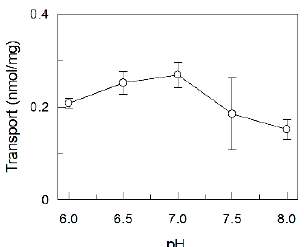
Figure 4 . Dependence of the riboflavin transport on substrate concentration. [ 3 H]Riboflavin was added to proteoliposomes at the indicated concentration. The transport measurement was stopped